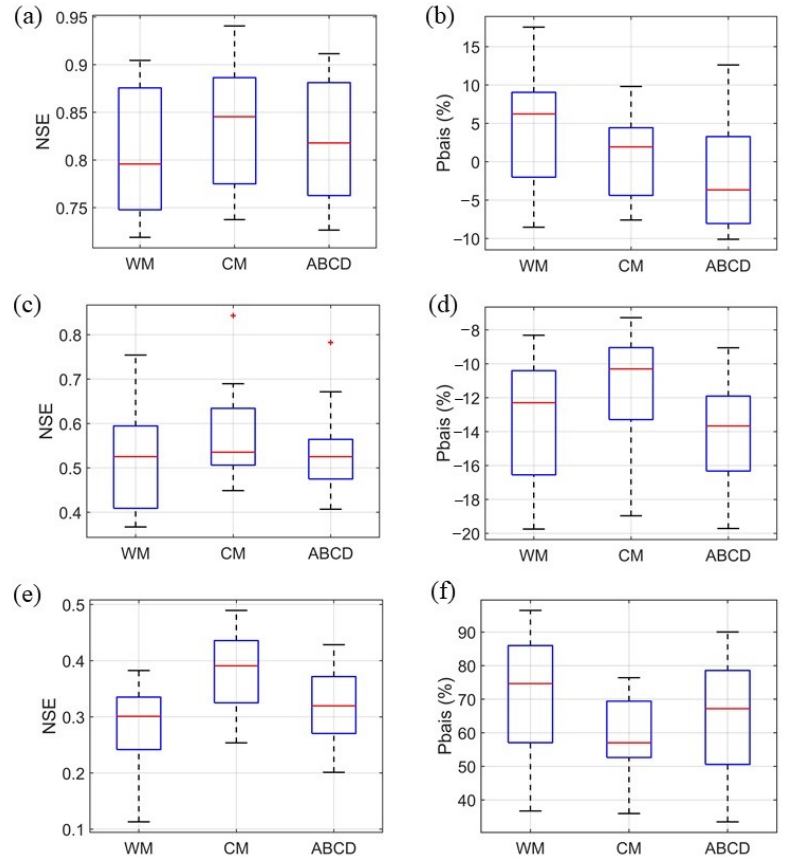
Figure 6. Simulation performance indicators box diagram in ( a , b ) all streamflow, ( c , d ) 75th percentile, and ( e , f ) 25th percentile for each model validation period.